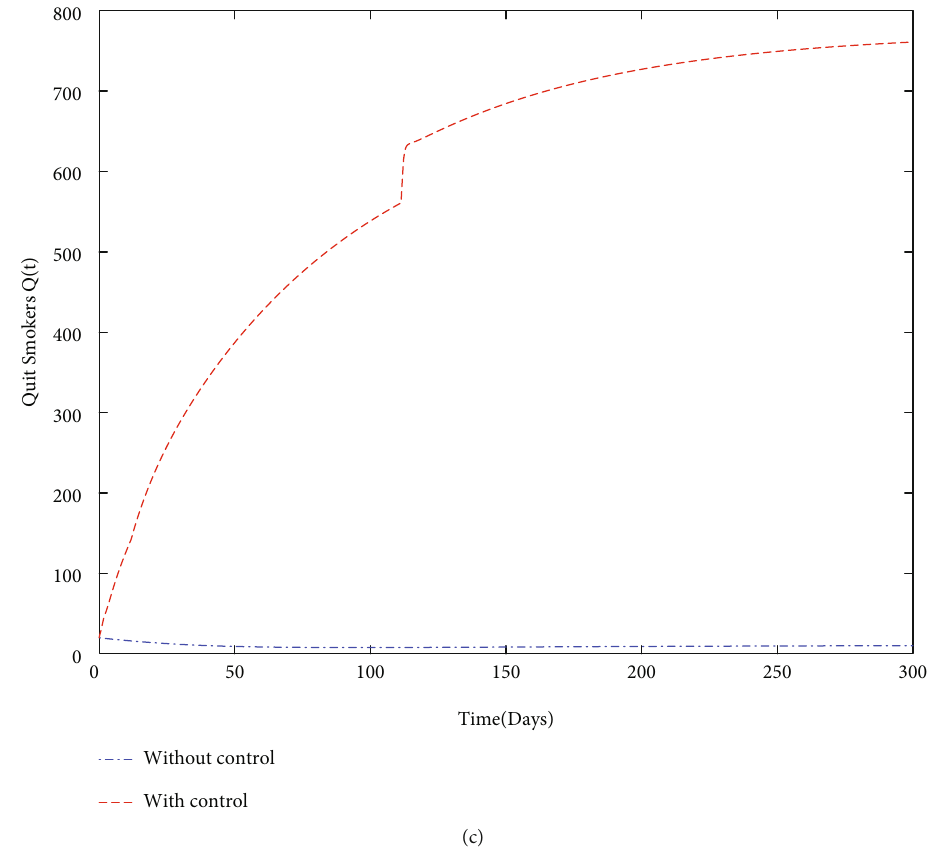
Figure 5: The plot describes stability of light smoker present equilibrium when R